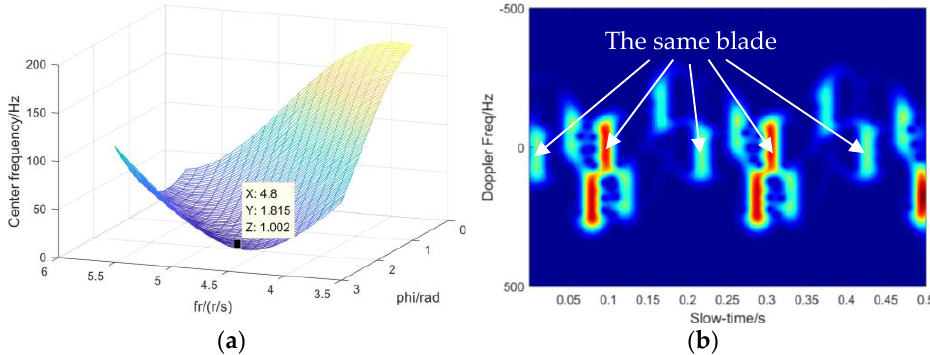
Figure 18. The simulated PO echoes: ( a ) the range profile of the PO echoes; ( b ) the TFD of the original echoes.